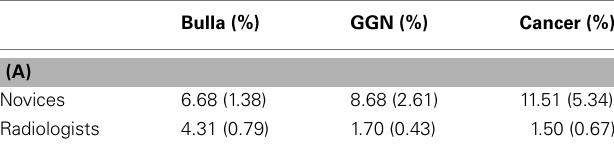
Table 2 |The summary of miss rates of target lesions collapsed over the